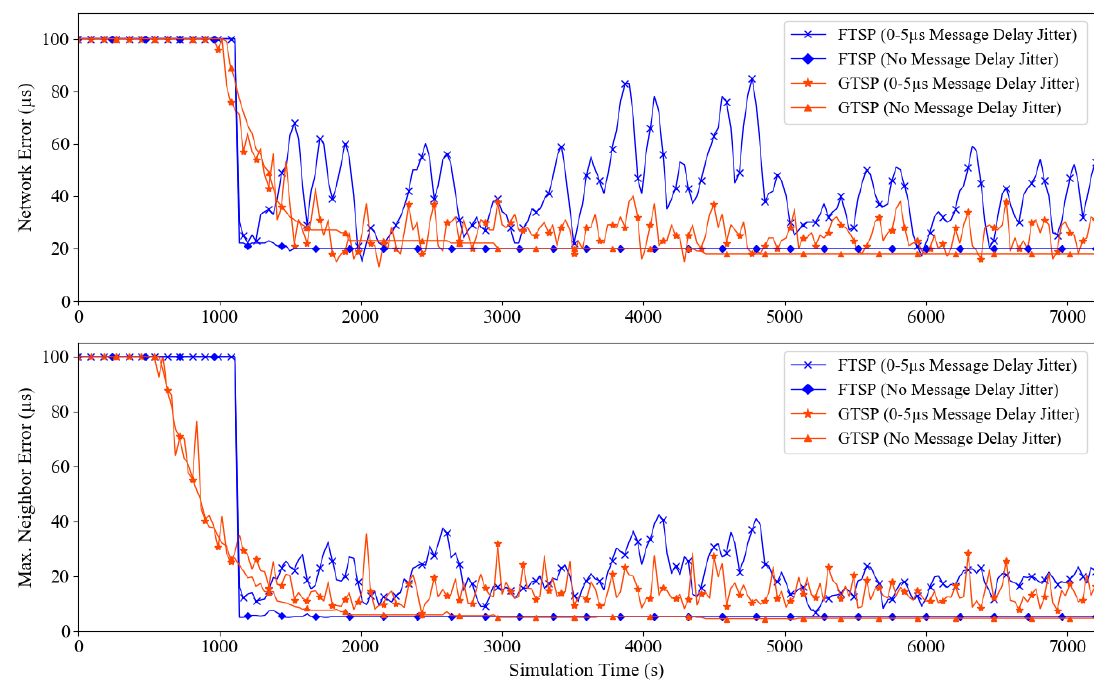
Figure 2. Network error and maximum neighbor error of FTSP and GTSP in two settings: without message delay and with delay jitter up to 5µs. Random seed = 10.